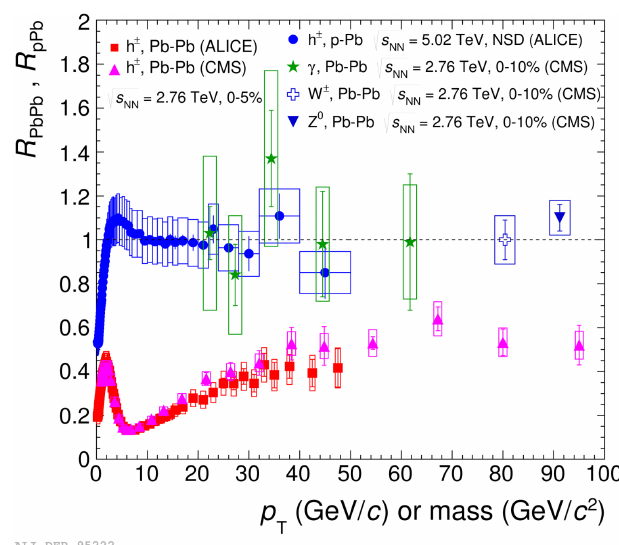
Figure 10. Nuclear modification factor R AA of hadrons measured by ALICE in p–Pb and Pb–Pb collisions [27].